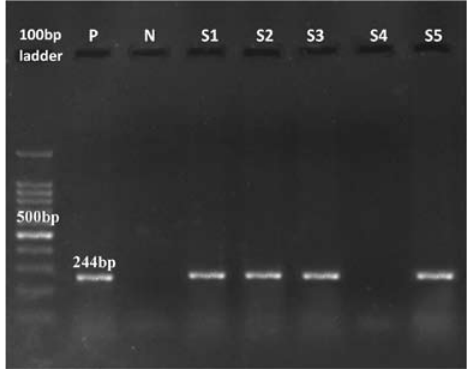
Fig.1 Agarose gel electrophoresis of PCR product – inv A gene